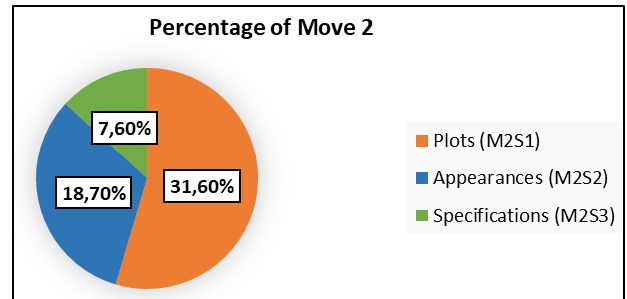
FIGURE 3 | Percentage of Move 2 Table 4 explicates the analysis of Move 2 had three